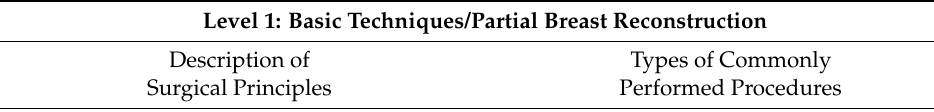
Table 1. Summary of oncoplastic surgery in breast-conservation